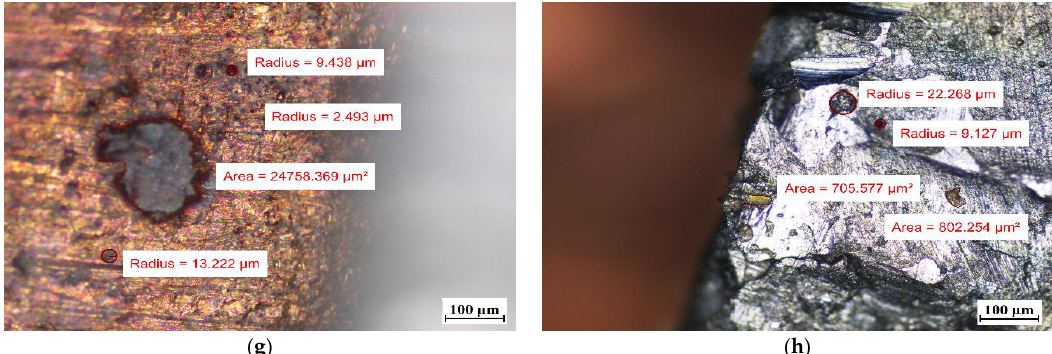
Figure 10. The surface of samples with a combination of copper and aluminum (Cu-Al) ( a ) before immersion in PCM – copper side; ( b ) before immersion in PCM – aluminum side; ( c ) after 7 weeks immersion in RT15 – cooper side; ( d ) after 7 weeks immersion in RT15 – aluminum side; ( e ) after 7 weeks immersion in RT18 HC – copper side; ( f ) after 7 weeks immersion in RT18 HC – aluminum side; ( g ) after 7 weeks immersion in RT22 HC – copper side; and ( h ) after 7 weeks immersion in RT22 HC – aluminum side.